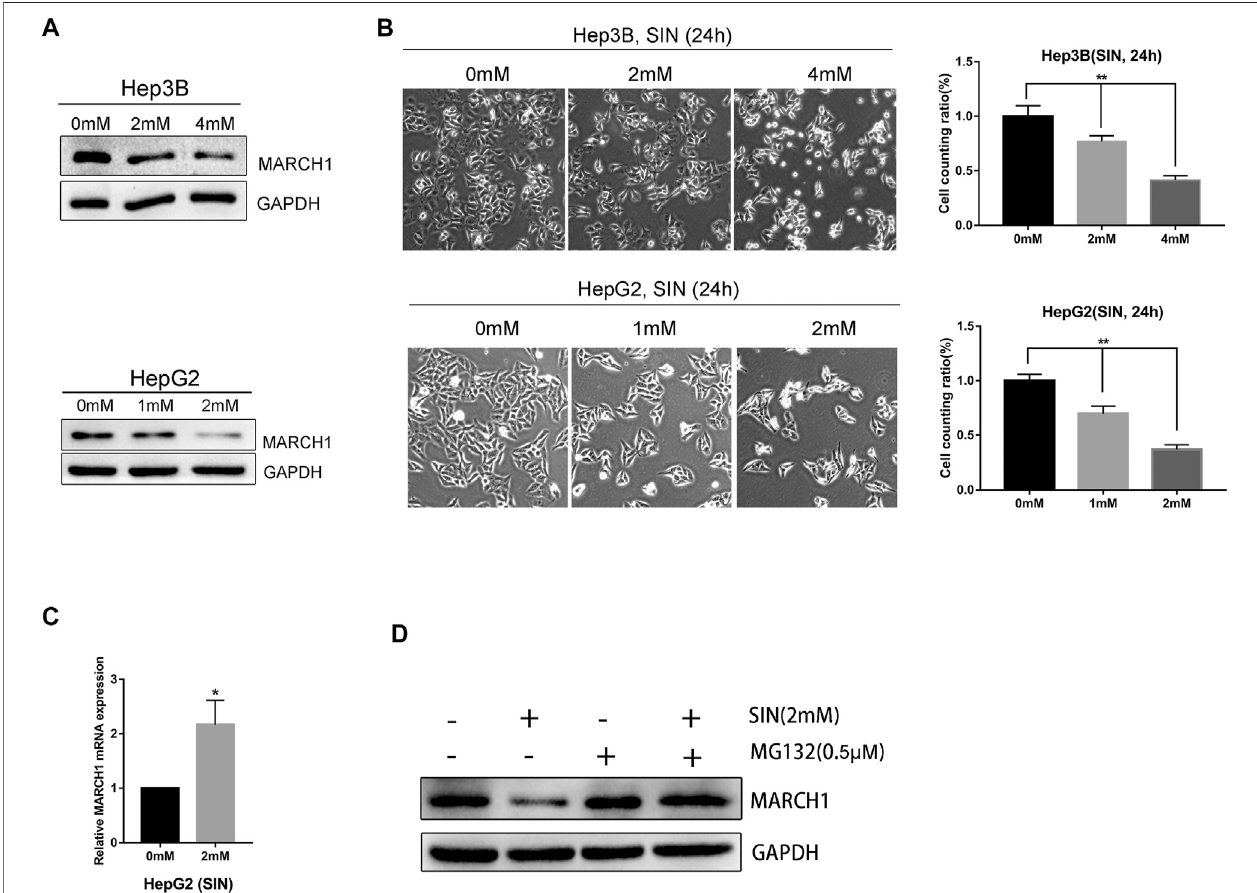
FIGURE 1 | SIN downregulated MARCH1 expression in HCC cells. (A) Western Blotting on the protein expression of MARCH1 in Hep3B and HepG2 cells treated with SIN. (B) The morphology of Hep3B and HepG2 cells treated with different concentrations of SIN for 24 h, the number of cells counted and analyzed. 0 mM as control. (C) qRT-PCR on the mRNA expression of MARCH1 in HepG2 cells treated with SIN. (D) Western Blotting on the protein expression of MARCH1 HepG2 cells treatedwithMG132(0.5 μΜ )andwithorwithoutSIN(2 mM).Alldataaremeans ± SDofresultsfromthreeexperiments.*represents p < 0.05,**represents p <